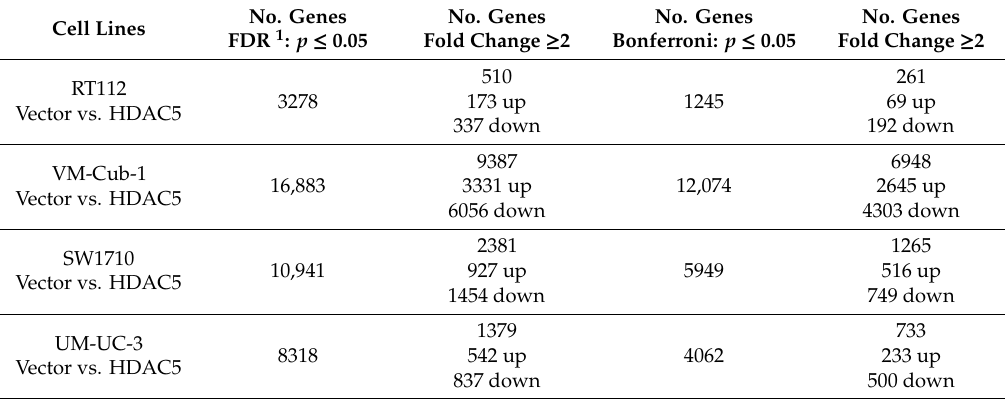
Table 2. Top canonical pathways in HDAC5 versus vector-only transduced UC cell lines.